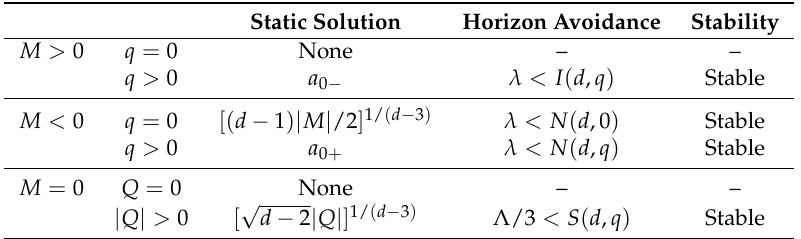
Table 4. The existence and stability of static wormholes in hyperbolic symmetry in four and higher